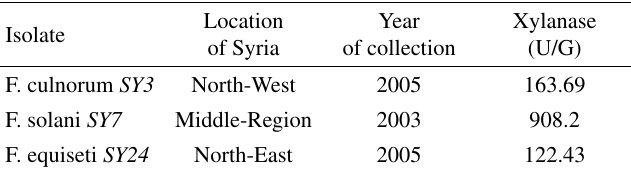
Table 1 - Fusarium isolates, location, year of collection and extra cel- lular xylanase production in solid state fermentation after